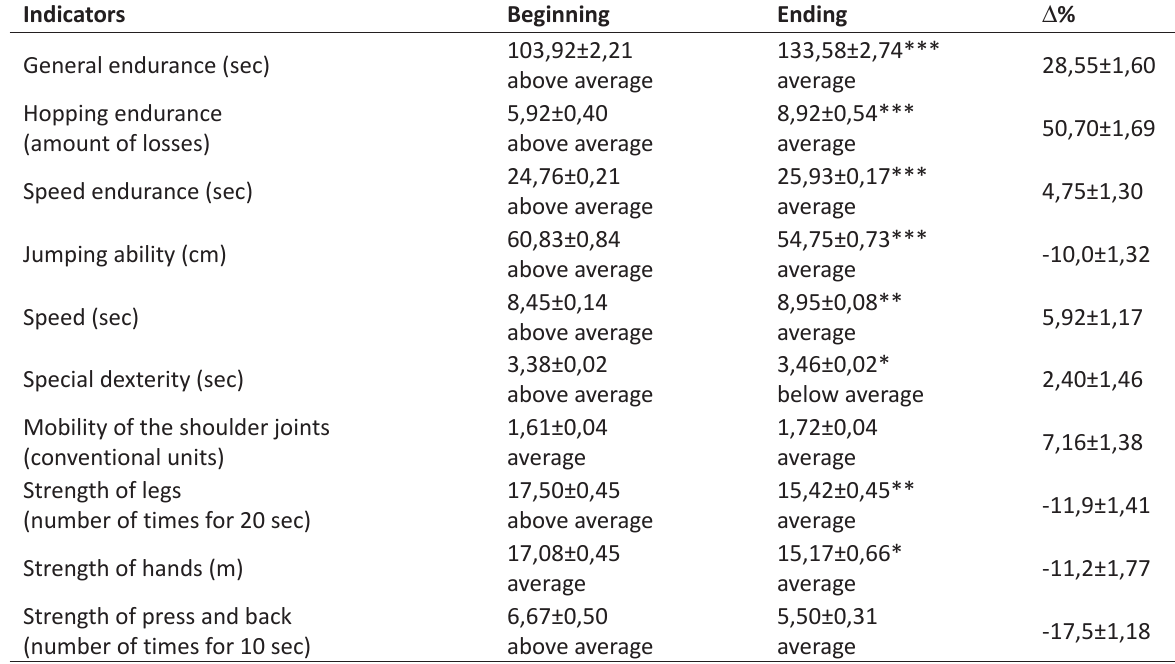
Table 2. Indicators of special physical preparedness of high qualification volleyball players at the beginning and end of the first stage of the experiment ( х ±S)